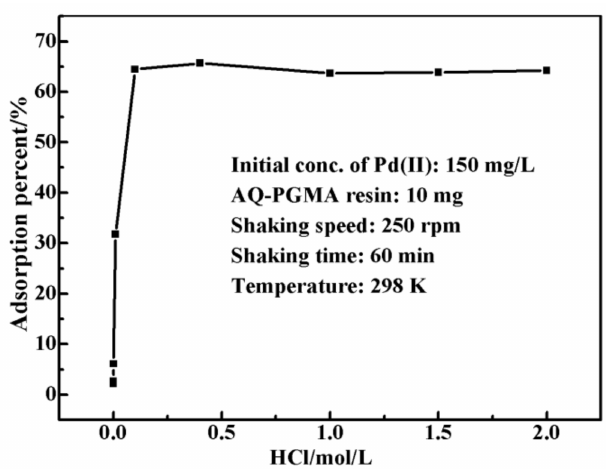
Figure 3. Effect of the HCl concentration on the adsorption of Pd(II) by AQ-PGMA.